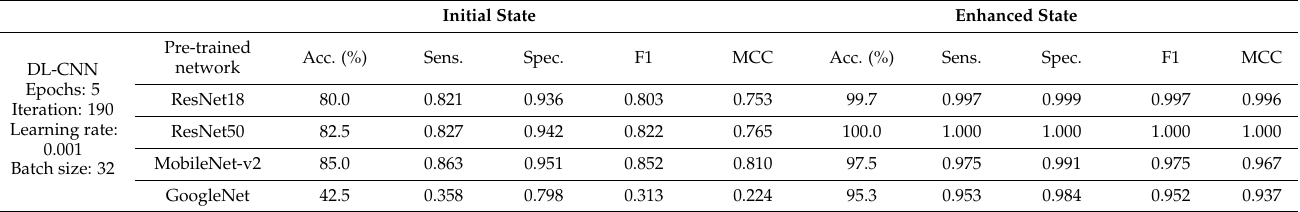
Table 9. HAR performance in local HS